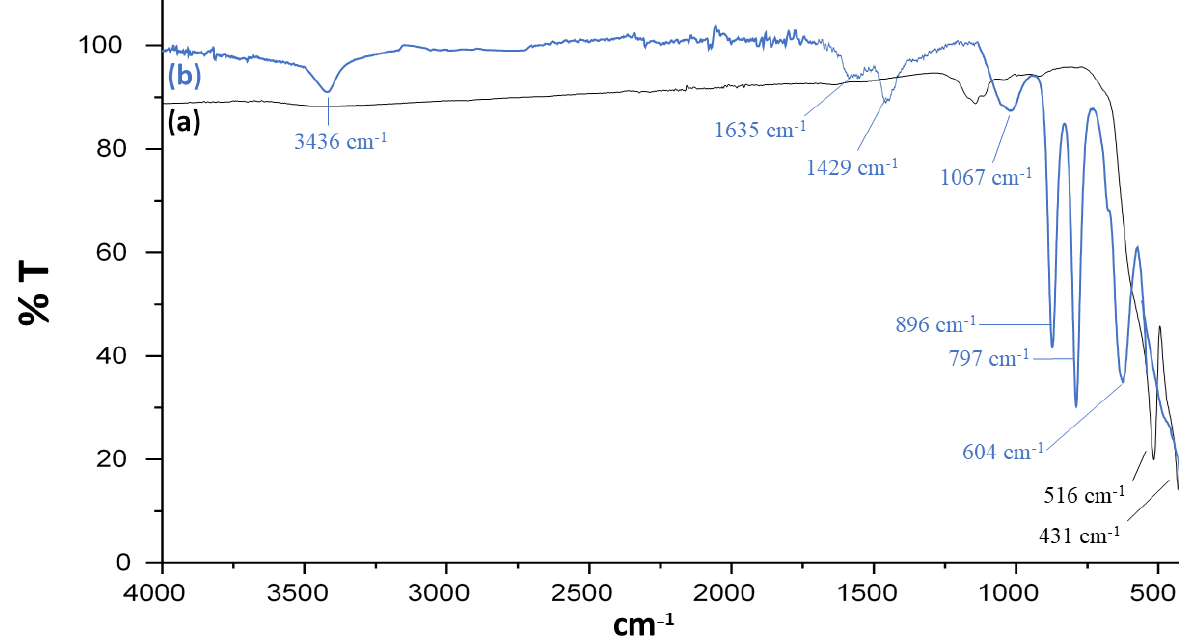
Figure 2. FT-IR spectra of ( a ) Fe 3 O 4 and ( b ) Fe 3 O 4 @SiO 2 @APTES. 3.1.2. SEM